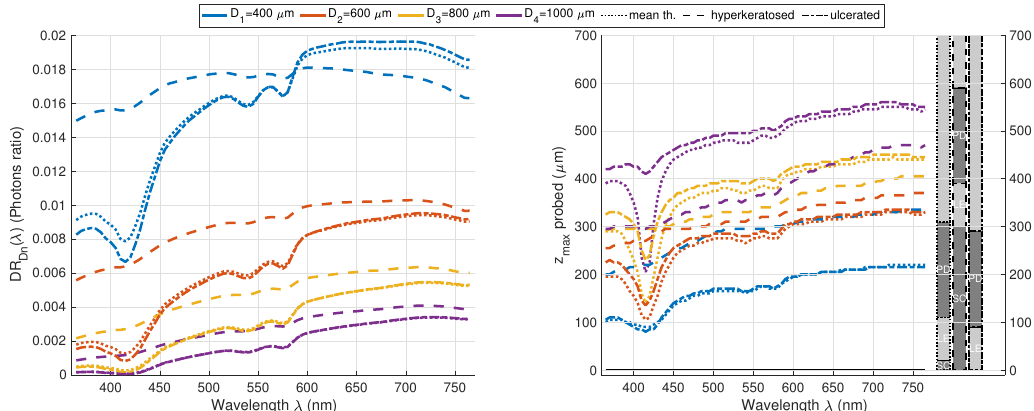
Figure 8. DR spectra ( left ) and maximum probed depth ( right ) for the simulated skin models: healthy (dotted line), hyperkeratosed (dashed) and ulcerated (dashed-dot). The SD distance D n is indicated by the color code. The three right columns represent the position of the border between the layers of each skin model (healthy, hyperkeratozed,